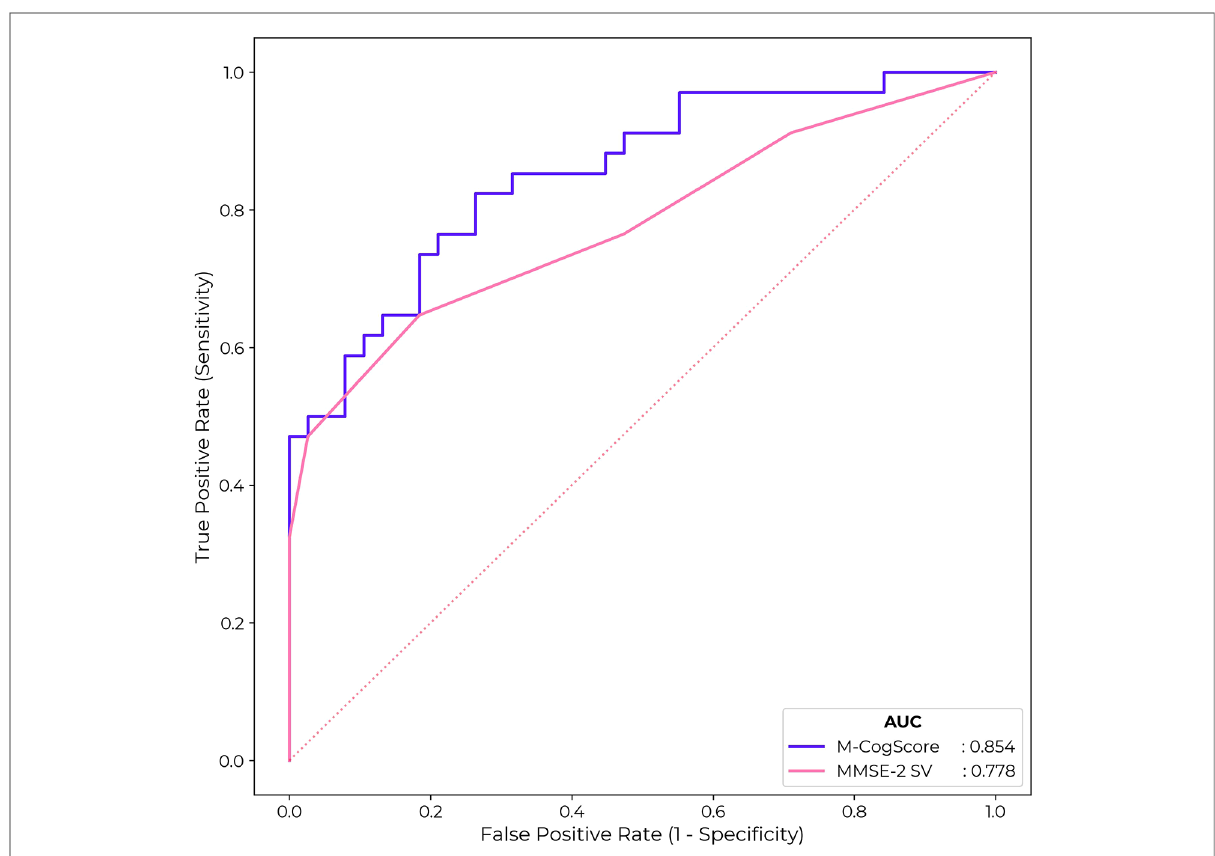
FIGURE 4 ROC for M-CogScore and MMSE-2 to detect impaired cognition based on CDR scores. M-CogScore AUC of 0.85 was non-signi fi cantly greater than that of MMSE-2 0.78 (DeLong p =0.21). The optimal threshold for MMSE-2 was 27 and for M-CogScore